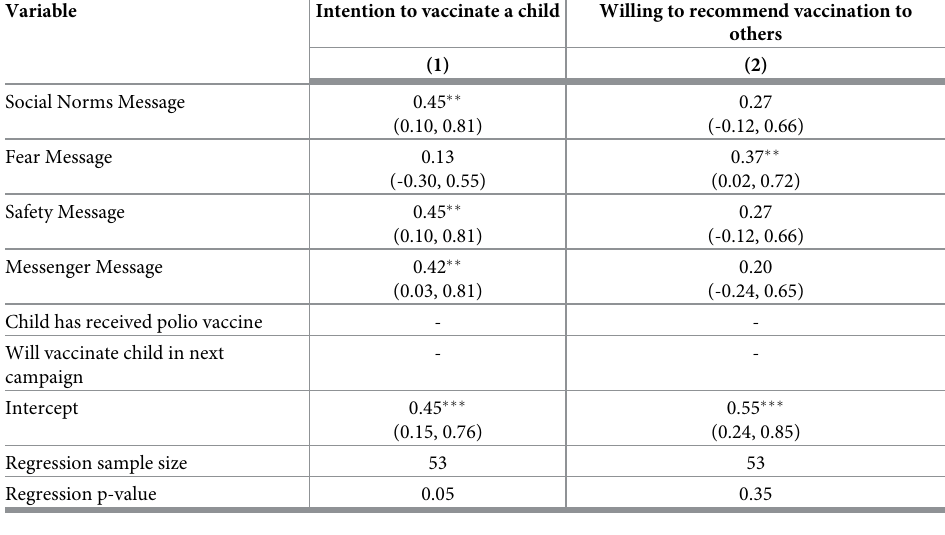
Table 6. Efficiency of the nudges with different message frames on the truncated sample of 53 vaccine-hesitant